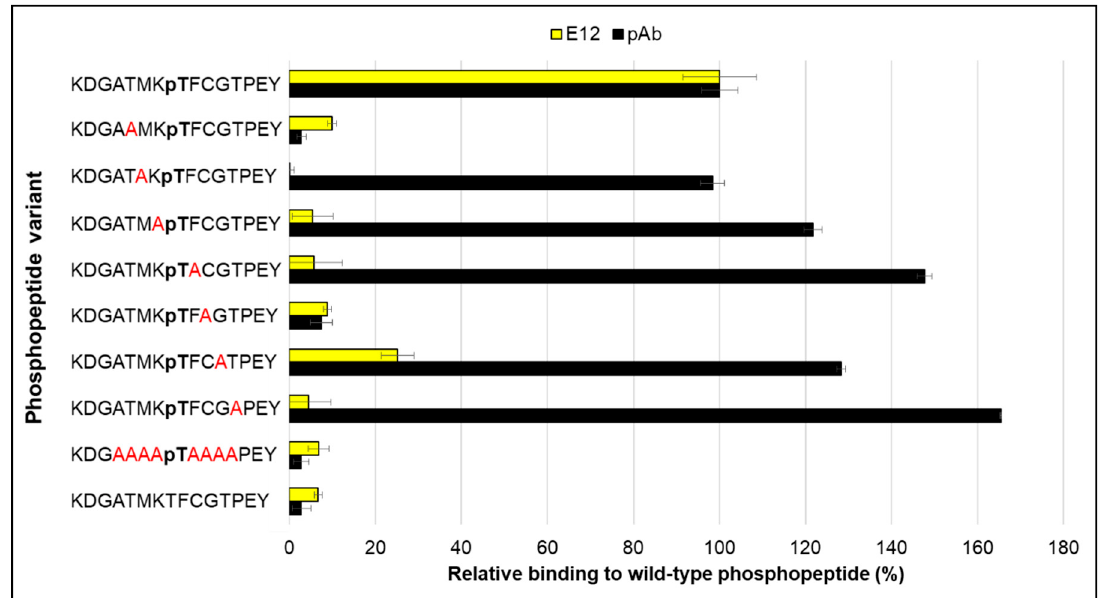
Figure 6. Identification of important residues on the peptide by alanine scanning. Alanine (A) was substituted one at a time at the − 3, − 2, − 1, +1, +2, +3 and +4 positions of the Akt1 peptide sequence. Binding of the E12 variant and a polyclonal antibody (pAb) to the wild type Akt1 peptide target was set to 100%, and the phosphopeptide variants were normalized against it in an ELISA. Error bars represent standard deviation of triplicate measurements.